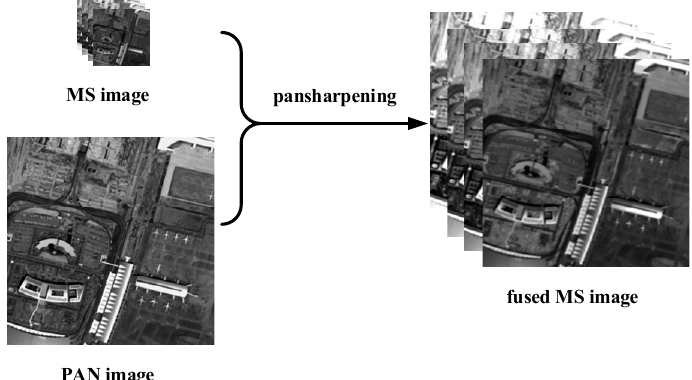
Figure 1. A schematic diagram of multispectral pansharpening.